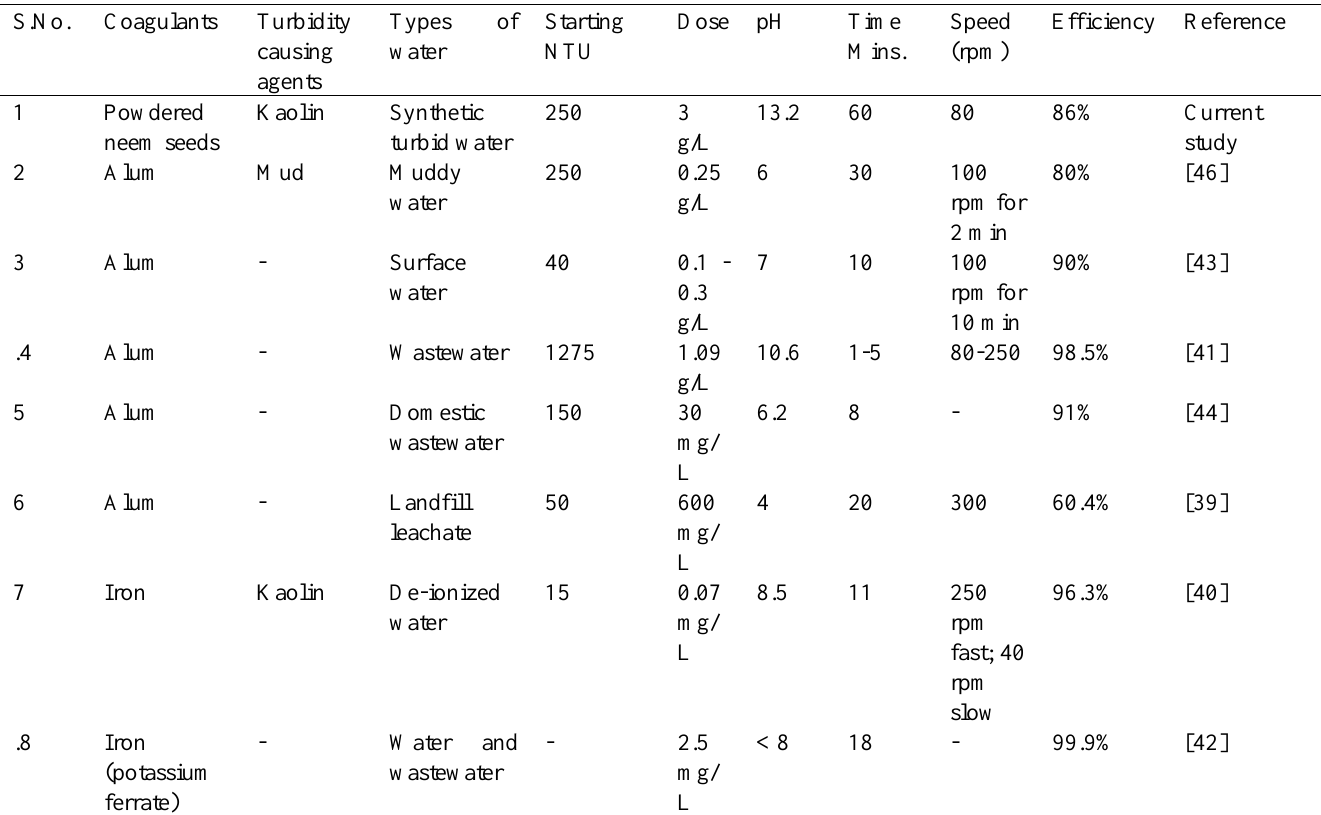
Comparison of powdered neem seeds as a bio-coagulant with conventional chemical coagulants